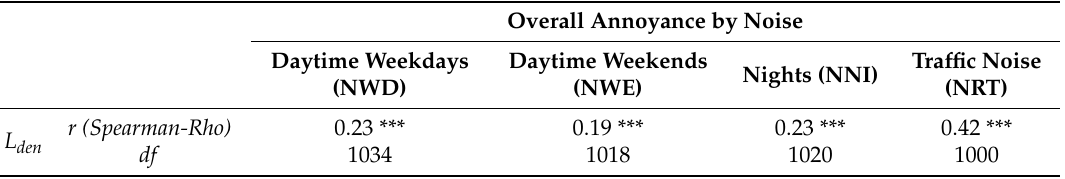
Table 4. Correlations of noise exposure ( L den ) and perception.